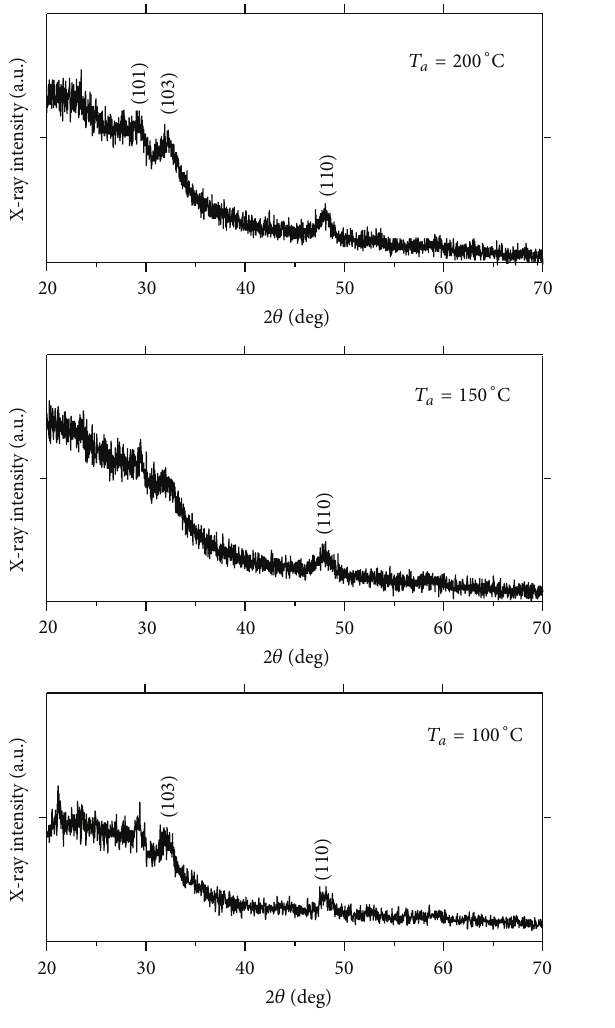
Figure 3: XRD patterns of the samples annealed in a vacuum atmosphere.